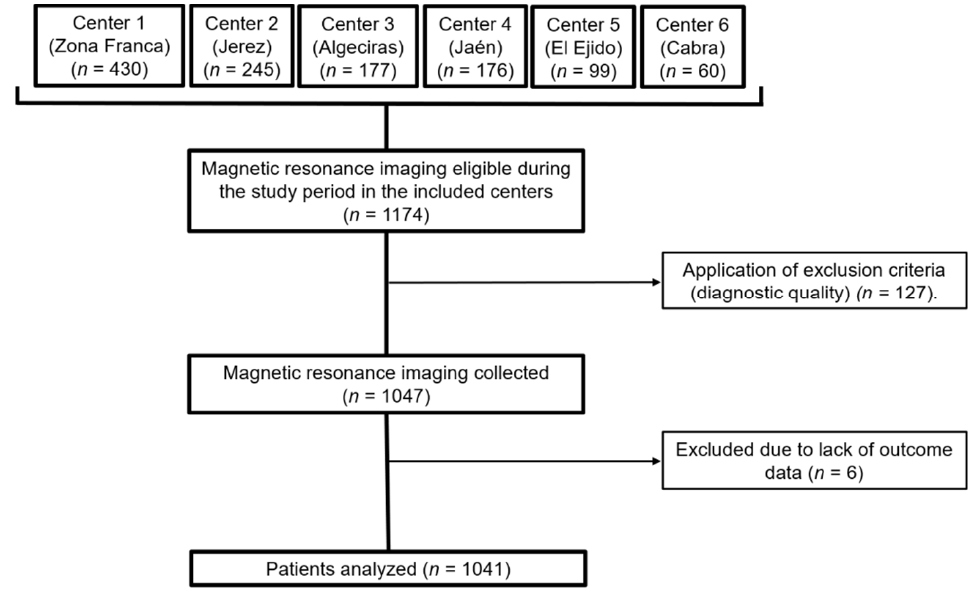
Figure 1. Flow diagram of the sample selection. MRI, magnetic resonance imaging.